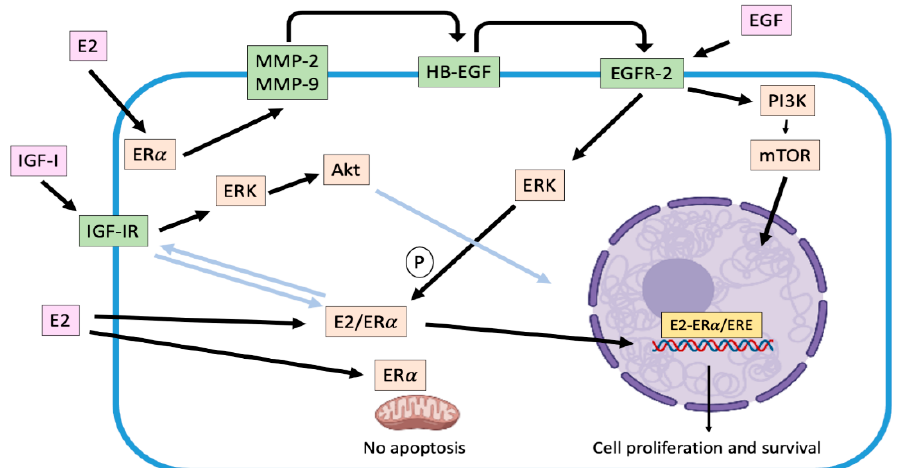
Figure 1. Representation of genomic and main non-genomic mechanisms associated with ER α activation in canine mammary carcinoma cells. Once activated by estradiol, ER α translocates from cytoplasm to nucleus, where it stimulates the transcription of several target genes (genomic effect). On the other hand, cross-talk between ER α and some growth factor receptors as EGFR-2 and IGF-IR are activated (non-genomic effects), which enhances the carcinogenic effects of the hormone. Light blue arrows indicate unconfirmed effects in canine mammary carcinoma cells. E2: estradiol; ER α : estradiol receptor α ; IGF-I: insulin growth factor I; IGF-IR: insulin growth factor I receptor; MMP-2/9: matrix metalloproteinases 2/9; EGF: epidermal growth factor; HB-EGF: heparin binding epidermal growth factor; EGFR-2: epidermal growth factor receptor 2; PI3K: phosphatidylinositol 3-kinase; mTOR: mammalian target pf rapamycin; ERK: extracellular-responses kinases; Akt: protein kinase B; ERE: estrogen response elements; P: phosphorylation.